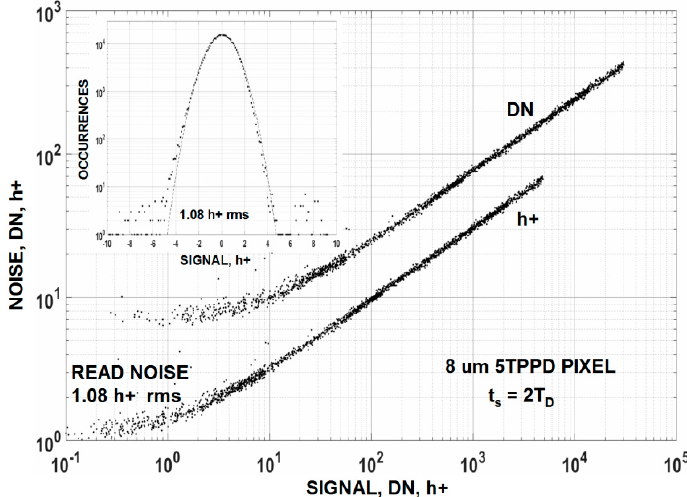
Figure 3. Photon Transfer curves demonstrating a read noise floor of ~1 hole rms. Most high performance CCD and CMOS imagers are close to this noise level. performance CCD and CMOS imagers are close to this noise